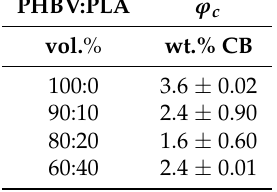
) in CB and BioC G